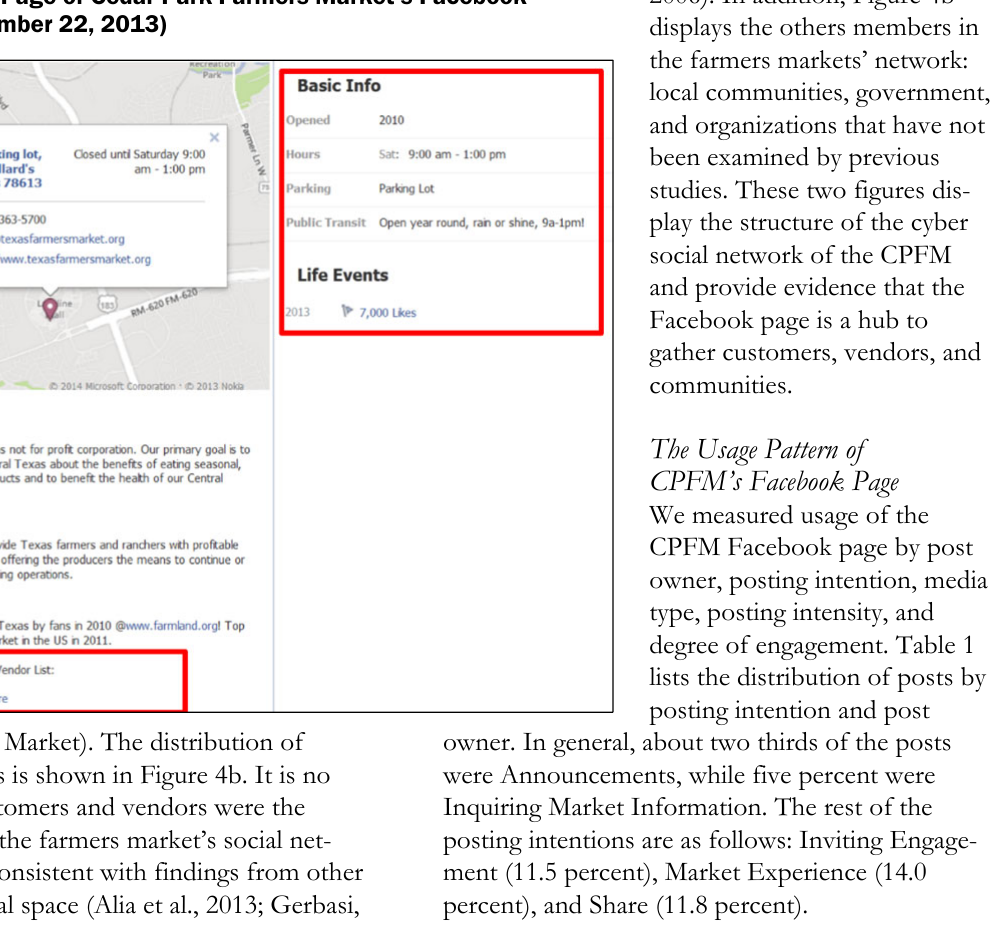
Figure 3. About Page of Cedar Park Farmers Market’s Facebook